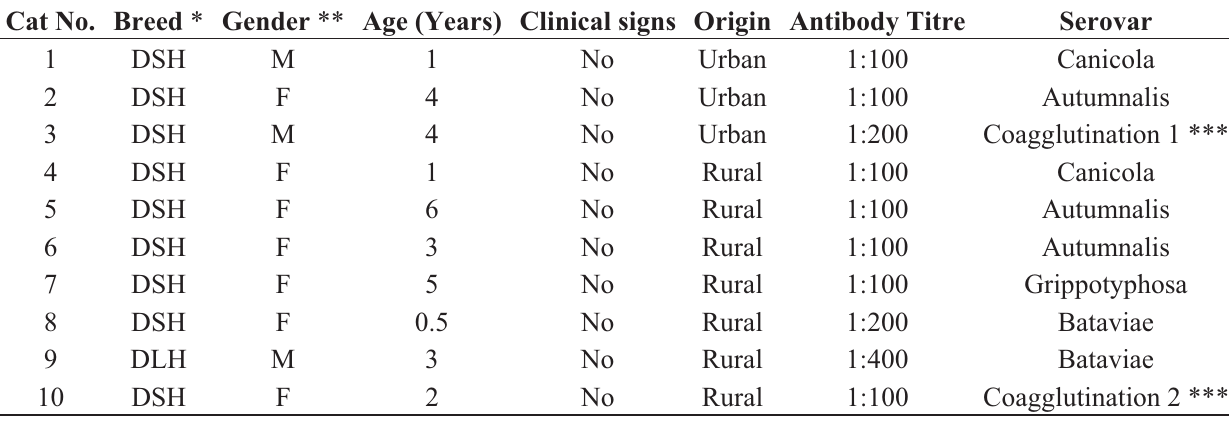
Table 2. Summary of the individual characteristics, origin, serovars, and antibody titres of 10 positive cats tested using